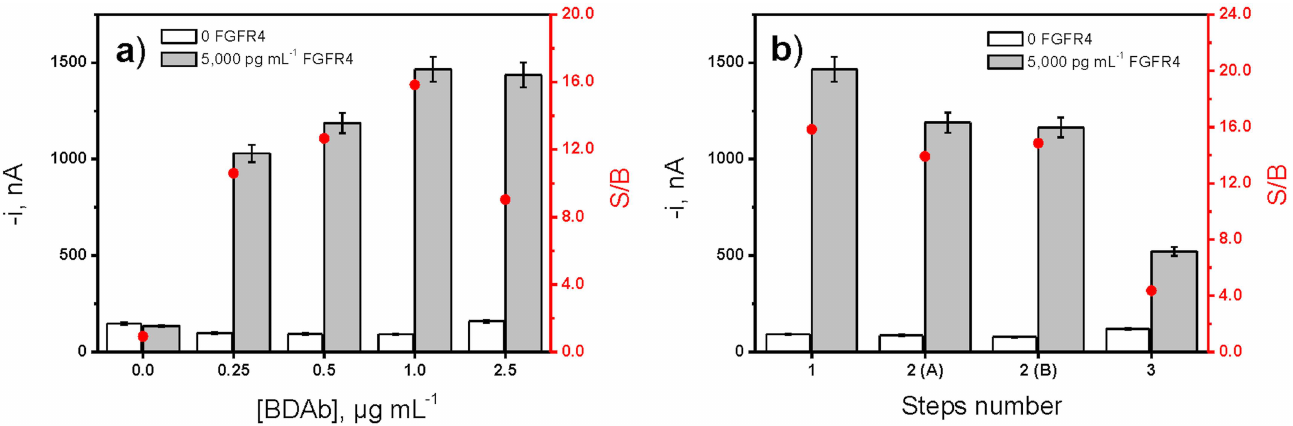
Fig 2. Dependence of the amperometric responses obtained with the developed immunosensor with the BDAb concentration (a), and the number of steps carried out to perform the immunoassay (b). Results are shown in the absence (white bars) or in the presenceof 5,000 pg mL -1 FGFR4 (grey bars) together with the corresponding S/B ratio ( (cid:15) ). 2(A), two sequential steps involving30 min incubation of the CAb-MBs in a mixture solution containing FGFR4 and BDAb, and 30 min incubation in the Strep-HRP solution; 2(B) two steps involving30 min incubationof the Cab-MBs with FGFR4 solution,followedby a 30 min incubationstep in a mixture solutioncontaining BDAb and Strep-HRP. Error bars estimated as triple of the standard deviation(n = 3).